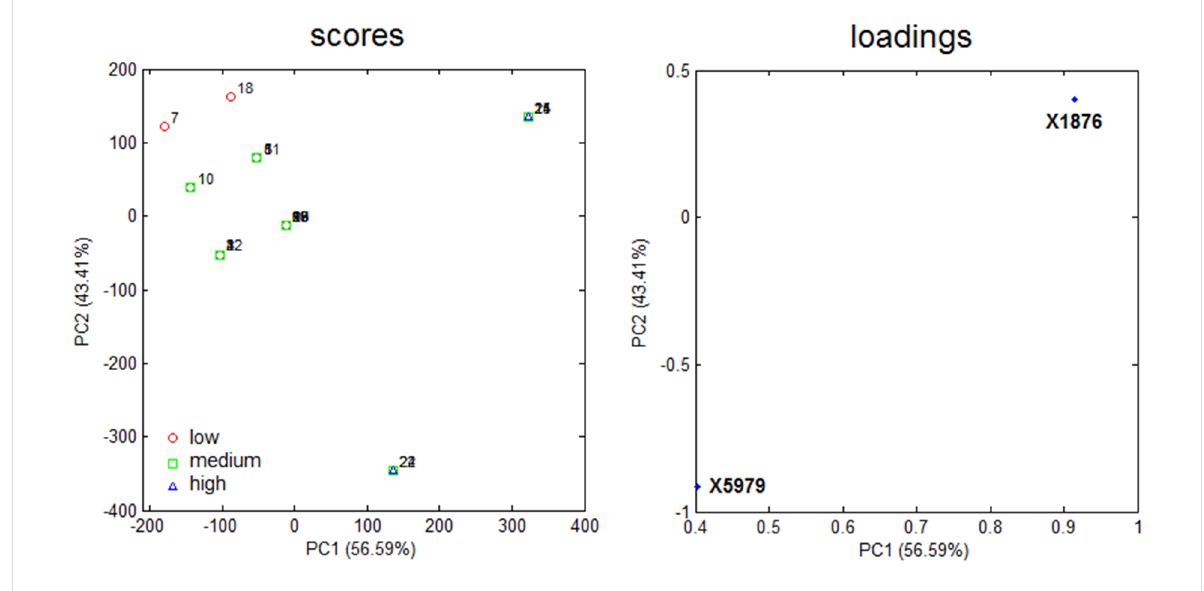
Figure 4: PCA plots for the mean-centered data of the 25 anesthetic haloethers.